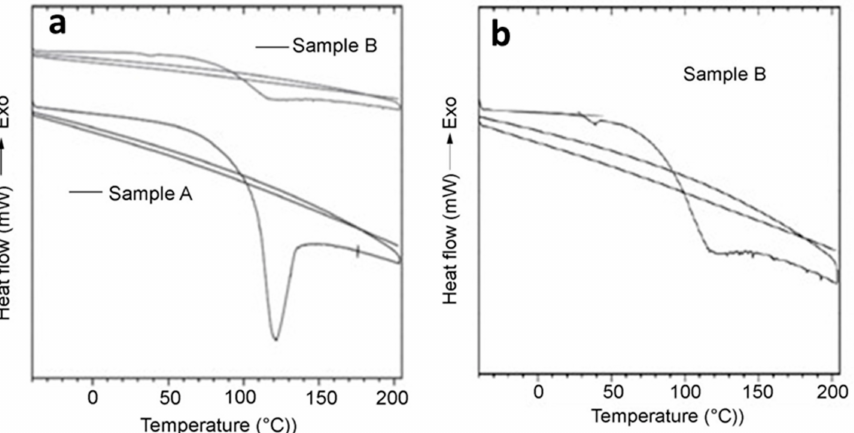
Figure 3. Differential scanning calorimetry (DSC) of hydrogels. ( a ) shows thermograms of sample 3-3 before (Sample A) and after (Sample B) lyophilization with three scans (heating/cooling/heating). ( b ) shows an expanded view of the thermal response (DSC) of sample